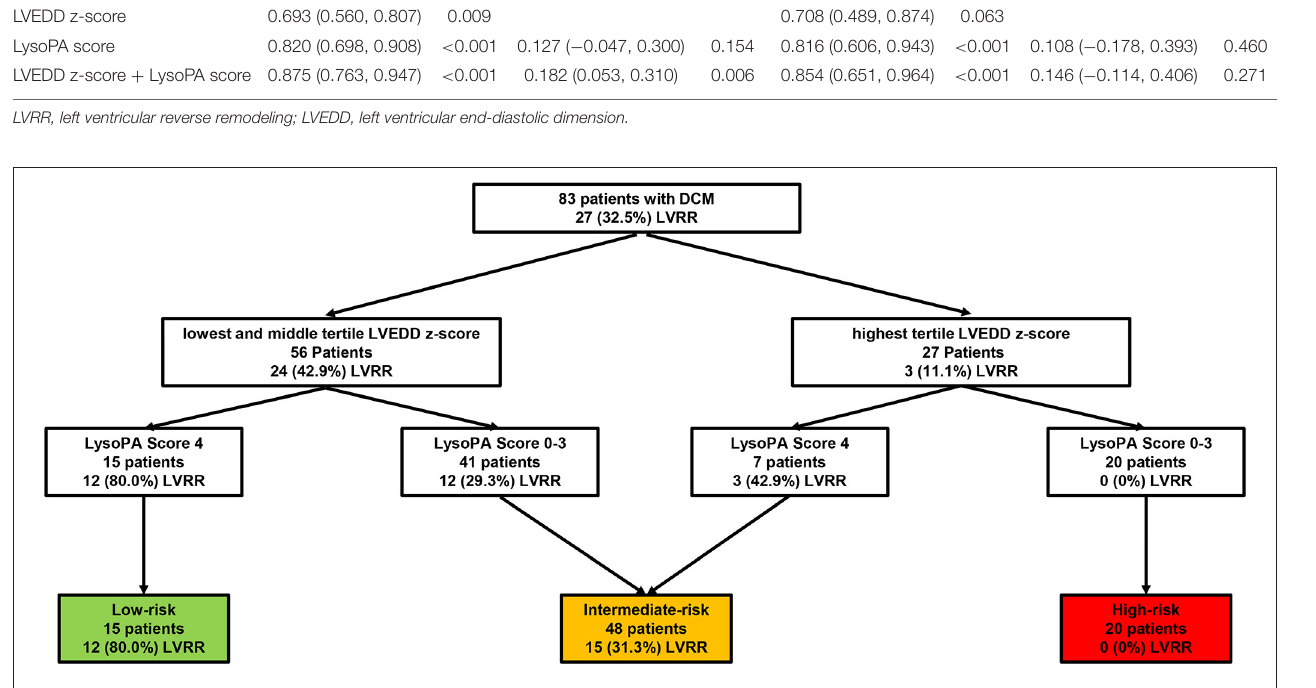
FIGURE 4 | Risk assessment strategy of patients with PDCM. The number (%) of patients with LVRR is shown for each step. Cutoffs were applied at LVEDD z-score in the highest tertile and LysoPA score = 4. PDCM, pediatric dilated cardiomyopathy; LVRR, left ventricular reverse remodeling; LVEDD, left ventricular end-diastolic